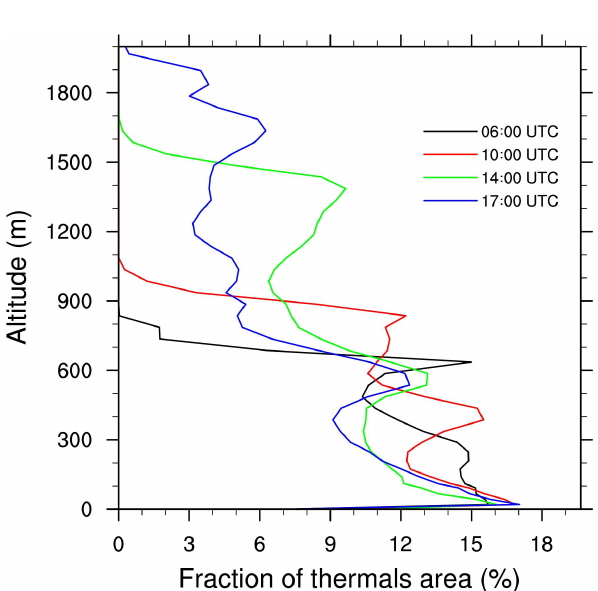
Figure 3. Vertical profiles of the fraction occupied by thermals at 06:00 (black), 10:00 (red), 14:00 (green) and 17:00UTC (blue).